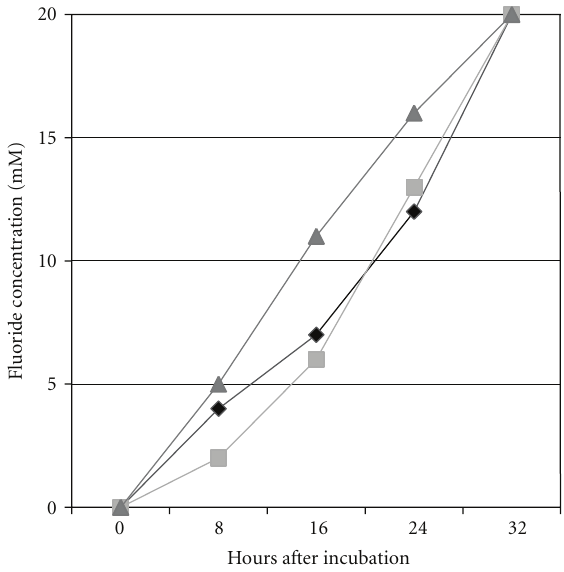
Figure 2: Sodium fluoroacetate degradation rate by bacteria isolated from caprine rumen. Isolate ECPB08 (light grey square), isolate ECPB09 (black rhombus), and P. fluorescens (dark grey triangle, positive